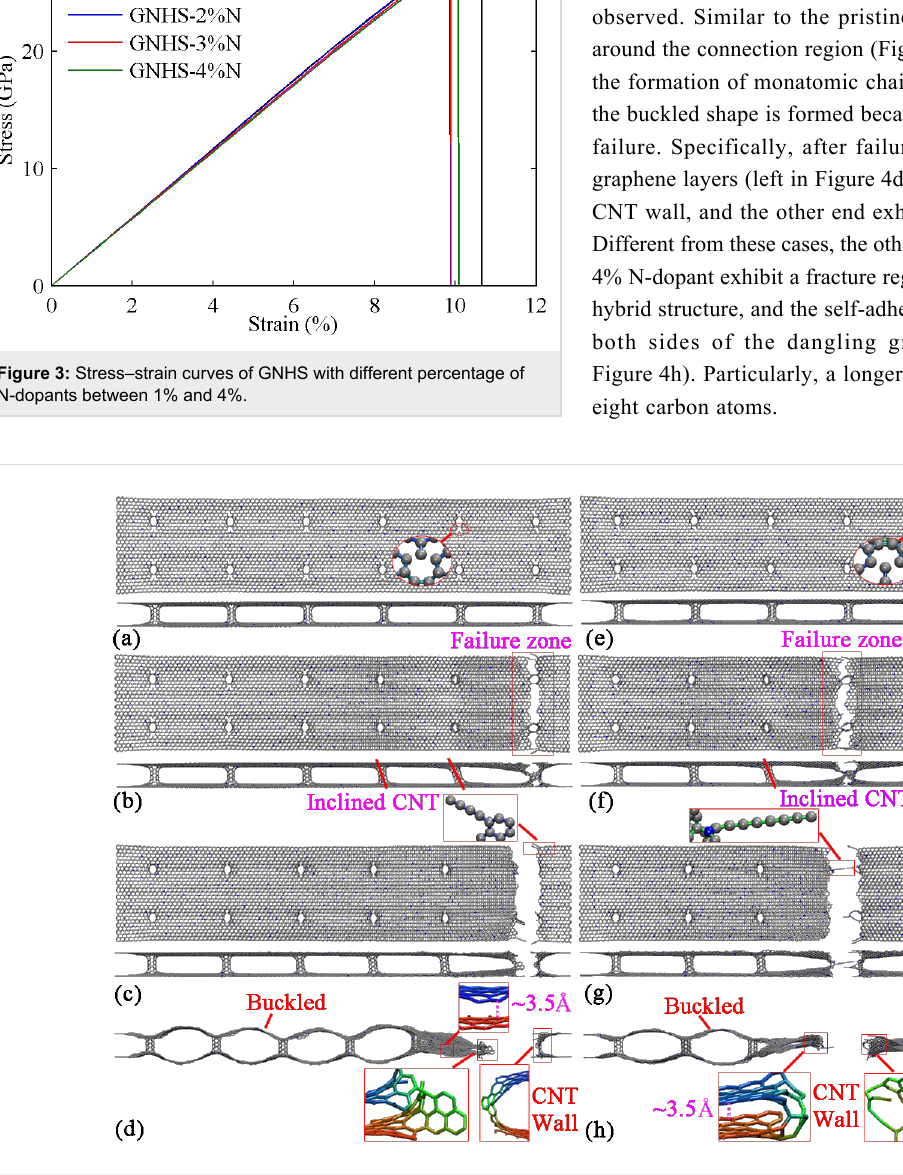
Figure 4: Atomic configurations of GNHS-2%N at a strain of: (a) 0.097; (b) 0.098; (c) 0.099, inset highlights the monatomic chain after the breaking of bonds; (d) 0.101, inset shows the dangling graphene layers. Atomic configurations of GNHS-3%N at the strain of: (e) 0.097; (f) 0.098; (g) 0.099; (h) 0.101.